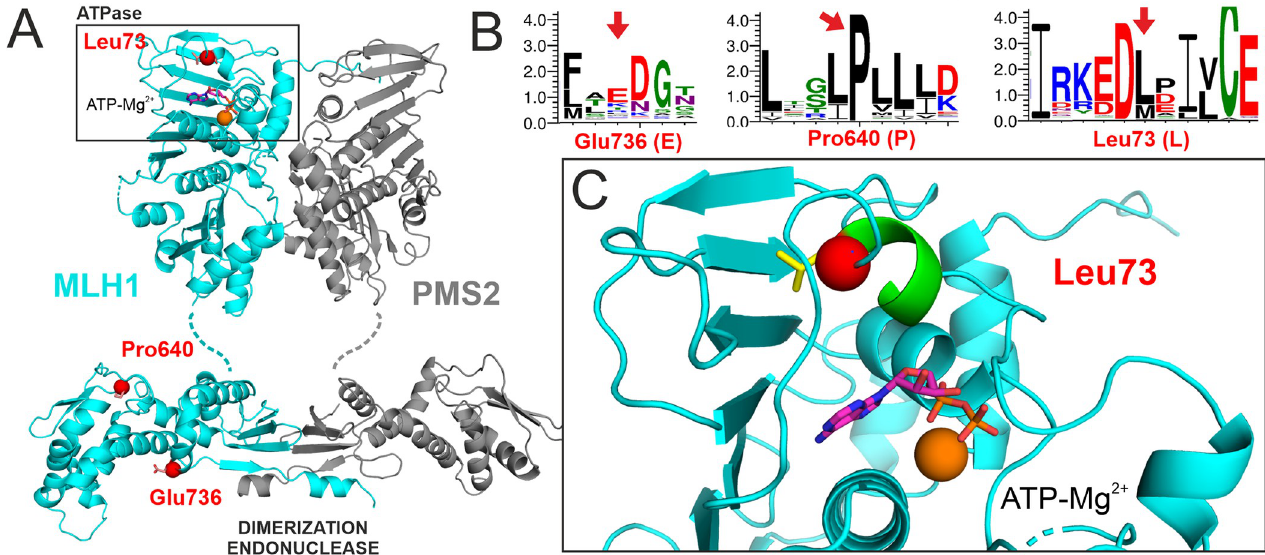
Fig 4. Structural positions of affected residues. A. The affected residues are shown as red balls in the structural model of the MLH1-PMS2 heterodimer (MLH1 shown in cyan, PMS2 in grey). The dimer comprises N-terminal ATPase domains (top, the bound ATP is shown in stick representation) in which the L73 residue is located. In the C-terminal domains, which confer dimerization and harbor the endonuclease function, the P640 and E736 residues are located. B. Weblogo presentation of sequence conservation of eukaryotic MLH1 in proximity of the three analyzed residues. These residues are marked by red arrows. Letter size corresponds to the degree of conservation. C. Detailed view of leucine 73 (red ball, side chain shown in yellow sticks) within the N-terminal ATPase pocket (area boxed in A). L73 is located within an α -helix (green) that contributes to formation of the nucleotide binding site. It engages in hydrophobic interactions with the extensive β -sheet forming the back of the ATPase